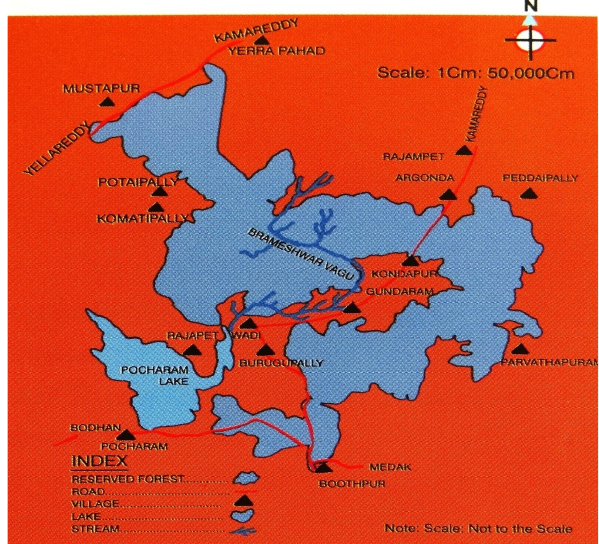
Fig. 1. The study area- outline of Pocharam wildlife